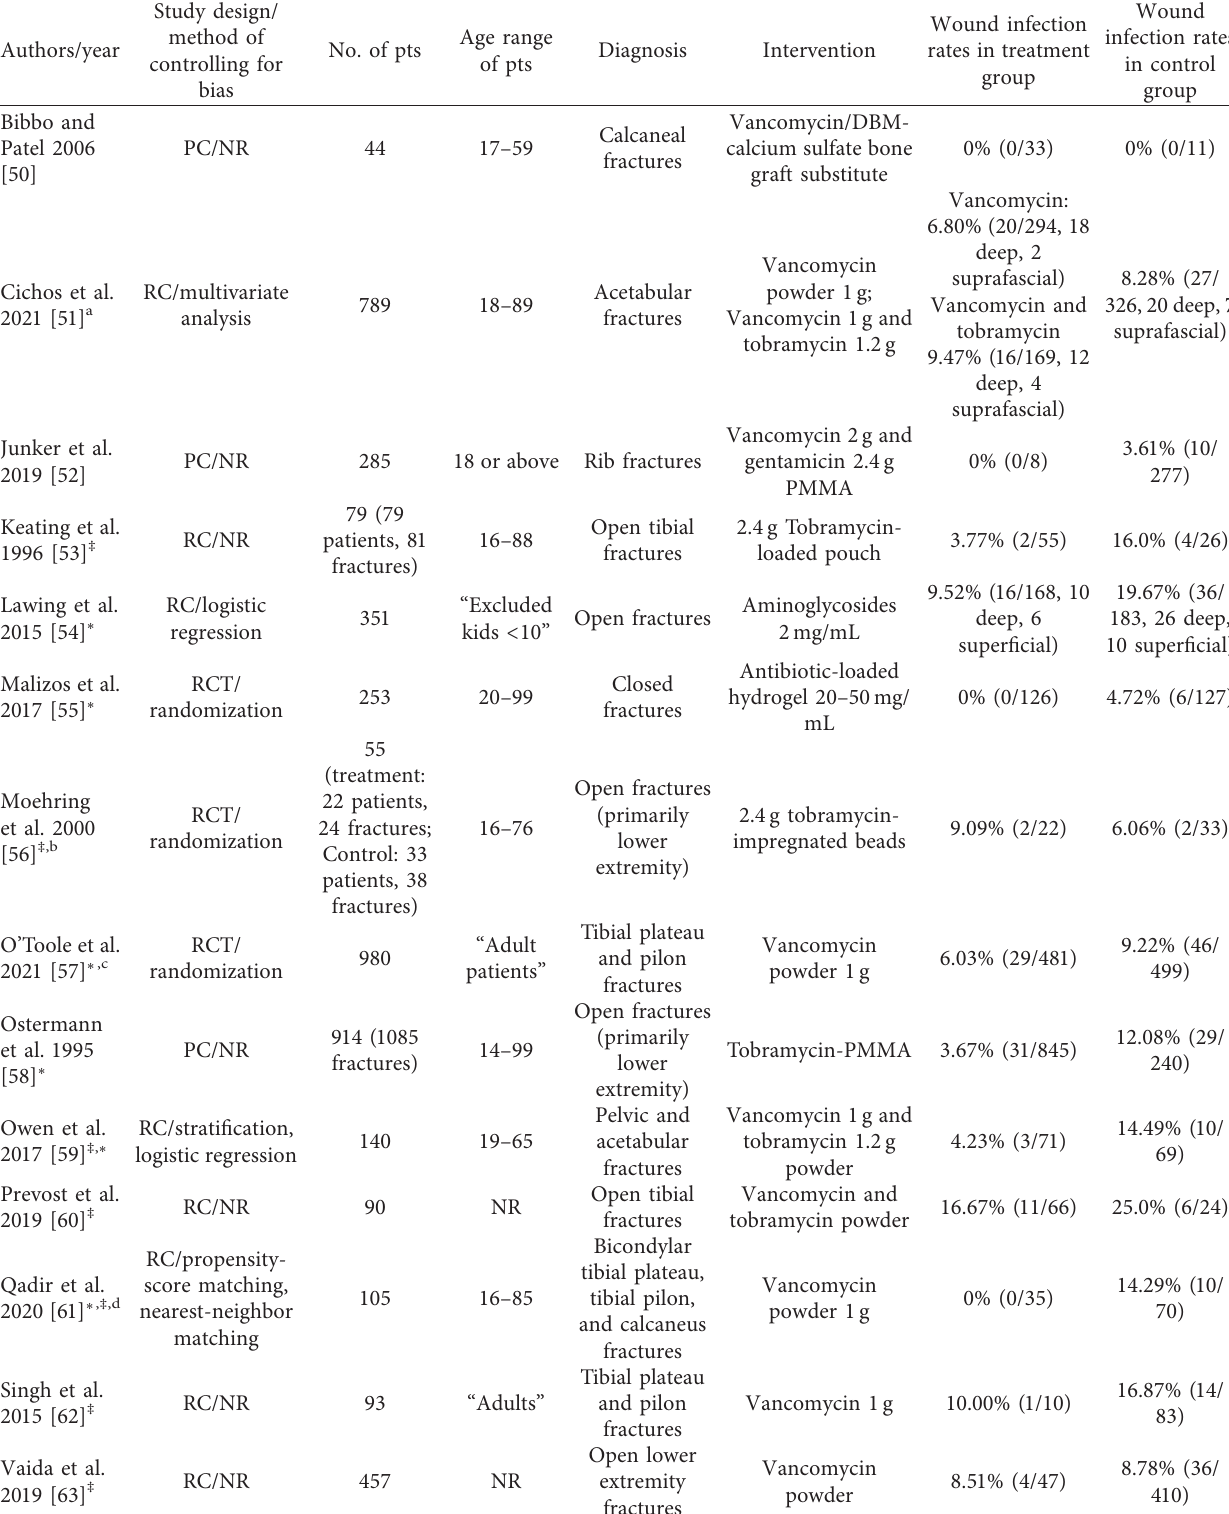
Table 2: Summary of infection rates and methodology of studies of fracture